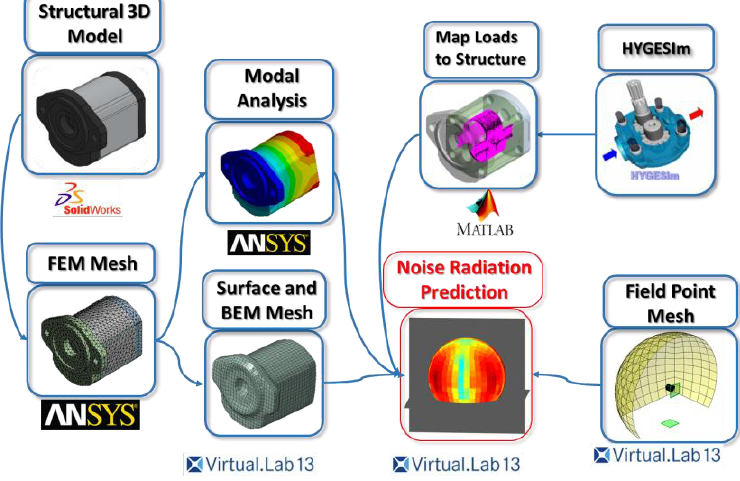
Figure 4. Overview of the vibro-acoustic model.